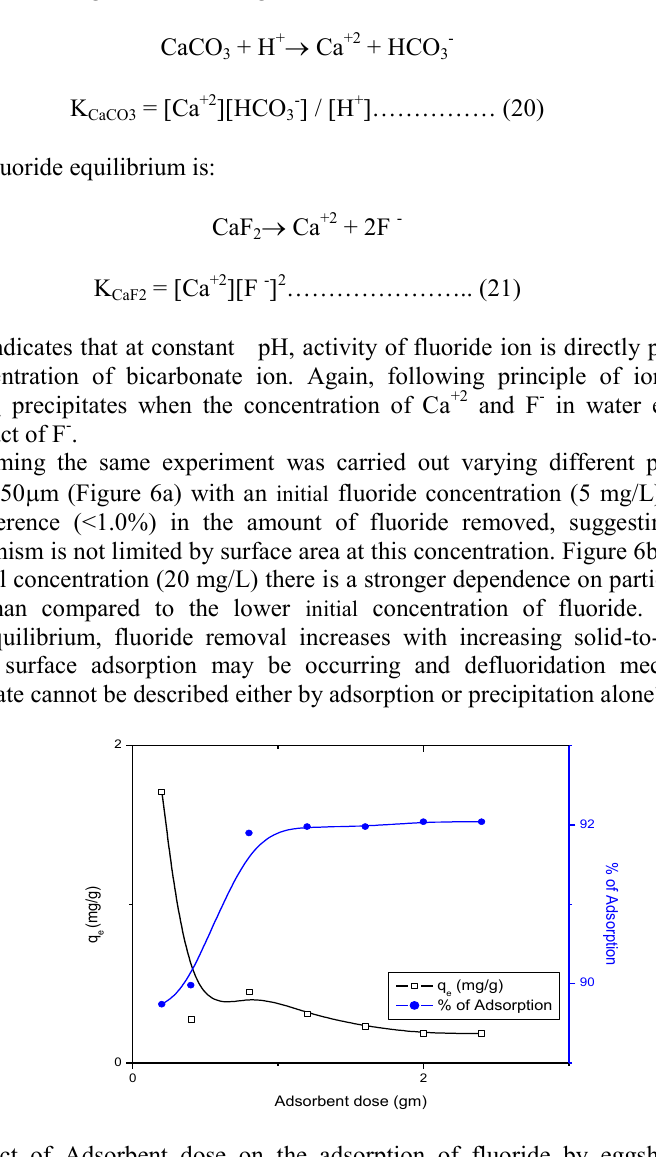
Figure 5. Effect of Adsorbent dose on the adsorption of fluoride by eggshell powder (experimental conditions: Initial fluoride concentration: 5.0 mg/L, pH: 6.0, agitation speed: 250 rpm, Contact time: 60 minutes, Temperature: 303